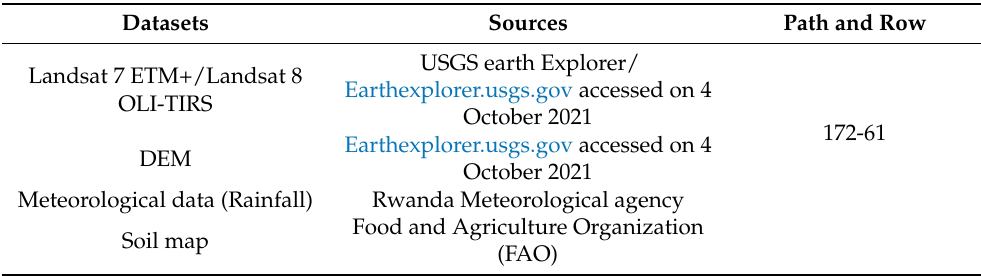
Table 1. Summary of datasets and their